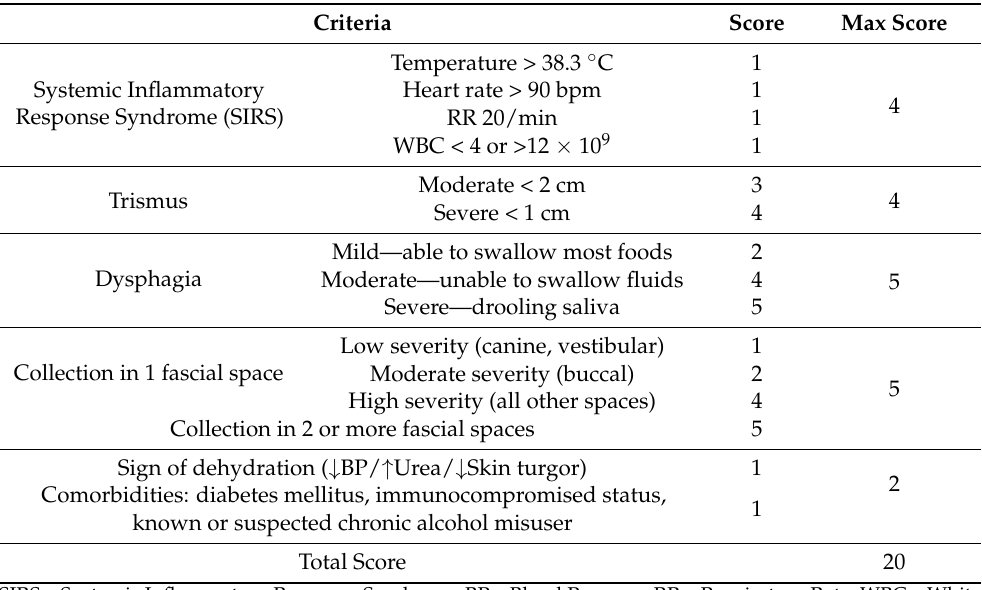
Table 1. The Symptom Severity score (SS) of odontogenic infections. Criteria Score Max Score Systemic